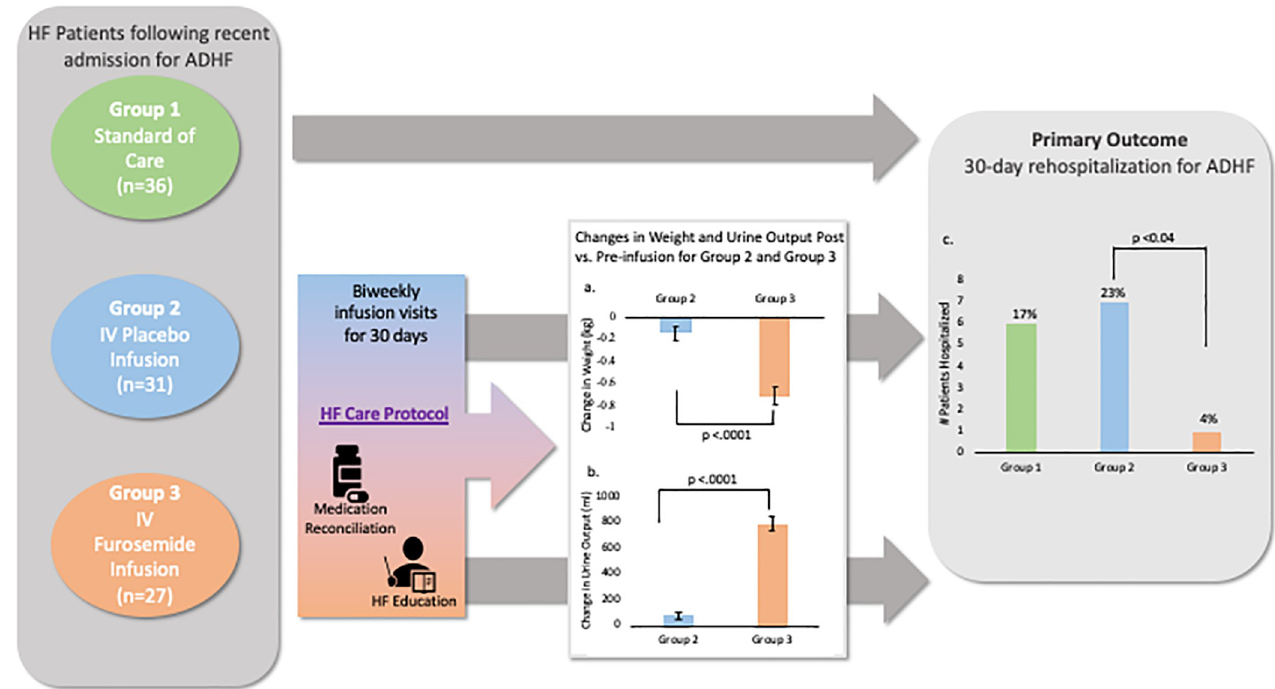
Fig 2. Study outcomes across randomization groups. Patients randomized to Group 1 (standard of care), Group 2 (intravenous placebo infusion), and Group 3 (intravenous furosemide infusion). Groups 2 and 3 underwent biweekly infusion visits for 30 days that included a HF-Care protocol. Changes in weight (a) and urine output (b) post- vs. pre-infusion for Group 2 and Group 3. Primary study outcome results (c) 30-day rehospitalization for ADHF in all three groups. ADHF, acute decompensated heart failure; HF, heart failure; IV, intravenous.